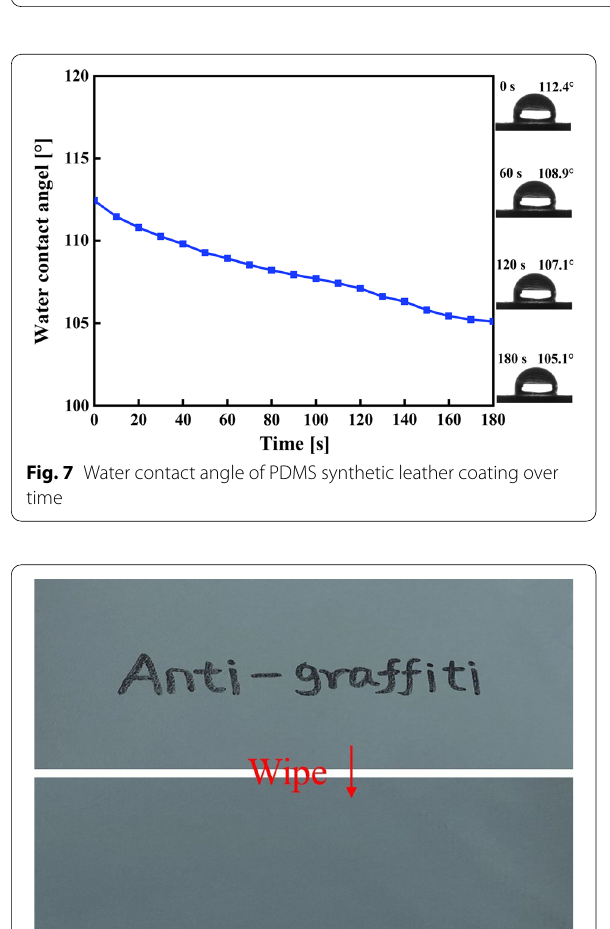
Fig. 6 Test results of abrasion resistance of different leather coatings